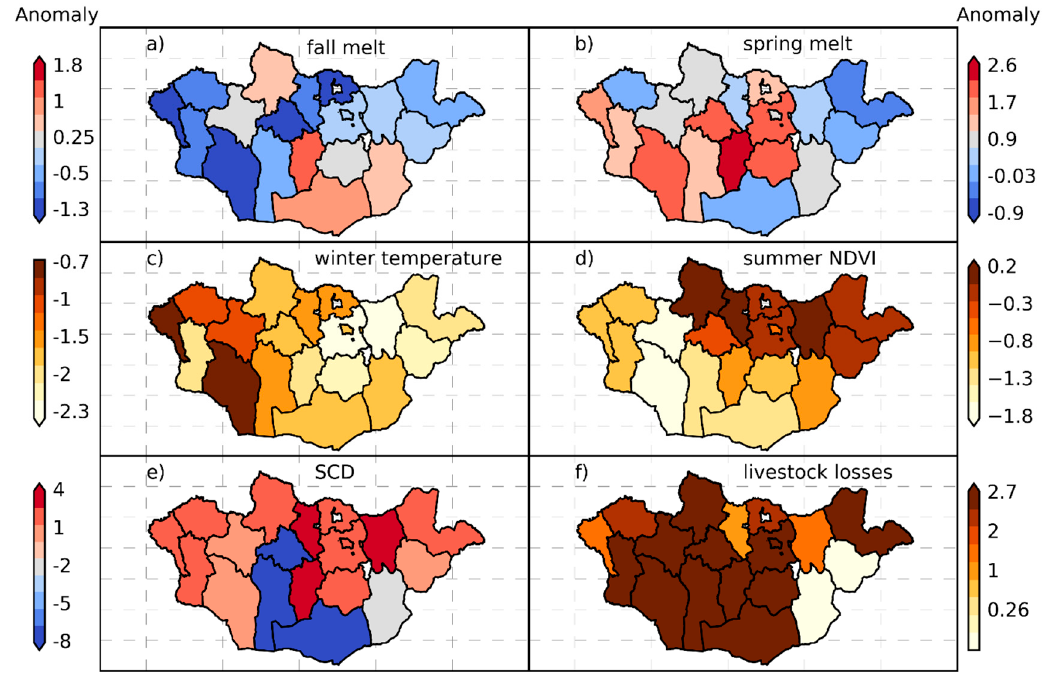
Figure 11. Standardized anomalies for fall melt events ( a ), spring melt events ( b ), winter temperature ( c ), summer NDVI ( d ), snow cover duration (SCD) ( e ), and livestock losses ( f ) during the dzud of 2010. Winter melt events are not included in the figure because they were only significantly correlated with a small number aimag livestock losses in 2010.